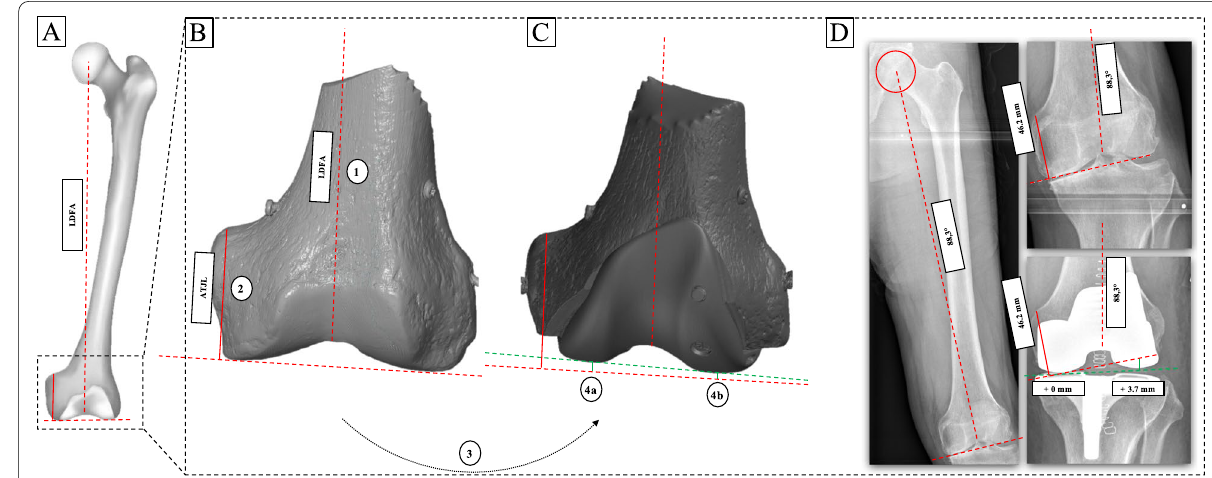
Fig. 4 Schematic illustration of radiographic measurement of medial and lateral joint line difference. Schematic illustration of a left femur with measurement of lateral distal femoral angle (LDFA) and adductor tubercle joint line distance (ATJL) ( a ). Preoperative ( b ) and postoperative distal femur ( c ). Preoperative LDFA (dashed) and ATJL (continuous) illustrated by red lines in ( b and c ). Green line shows postoperative joint line and perpendicular distance from most distal medial and lateral points to preoperative joint line. 1.) Measurement of preoperative LDFA in °, 2.) measurement of preoperative ATJL in mm as perpendicular distance from the adductor tubercle and the preoperative joint line ( ≜ LDFA), 3.) reconstruction of the preoperative LDFA and ATJL in the postoperative radiograph and 4.) measurement of the medial ( a , mJLD) and lateral ( b , lJLD) distance between the most distal point and the preoperative joint line. Example measurement ( d ) of the medial and lateral joint line alteration including example values of the ATJL, LDFA, mJLD and lJLD